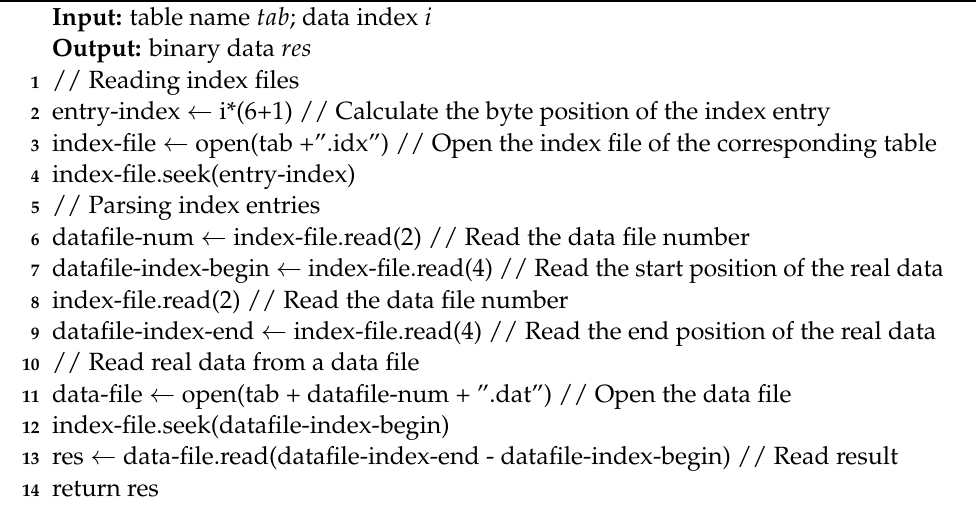
Algorithm 2: Data location algorithm for a flat